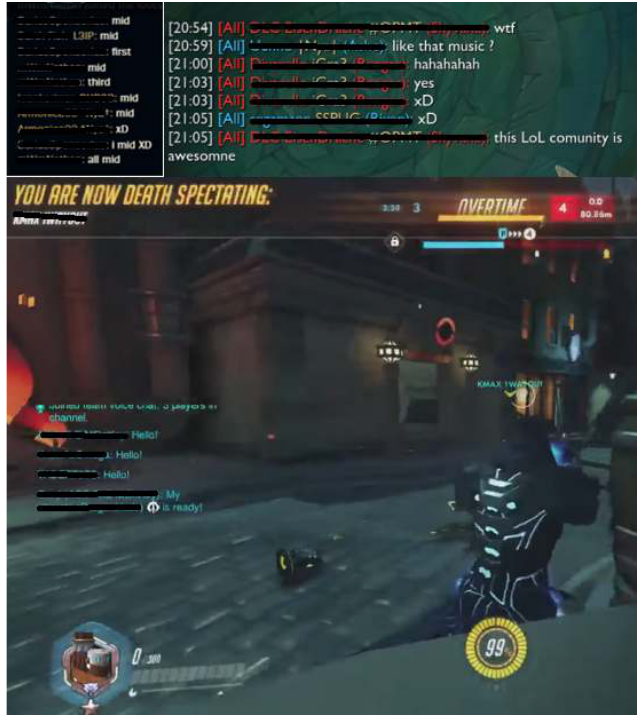
Players’ names have been obscured for